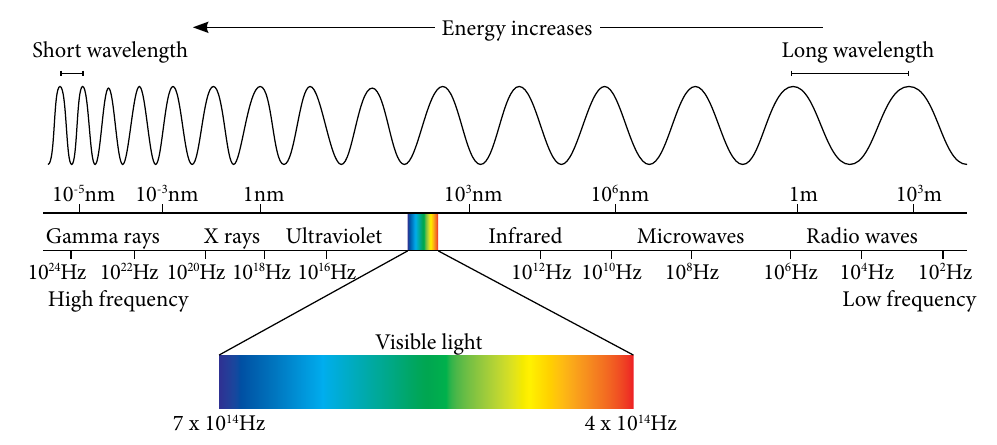
Figure 1. Electromagnetic spectrum. (Source: Bidinotto et al .